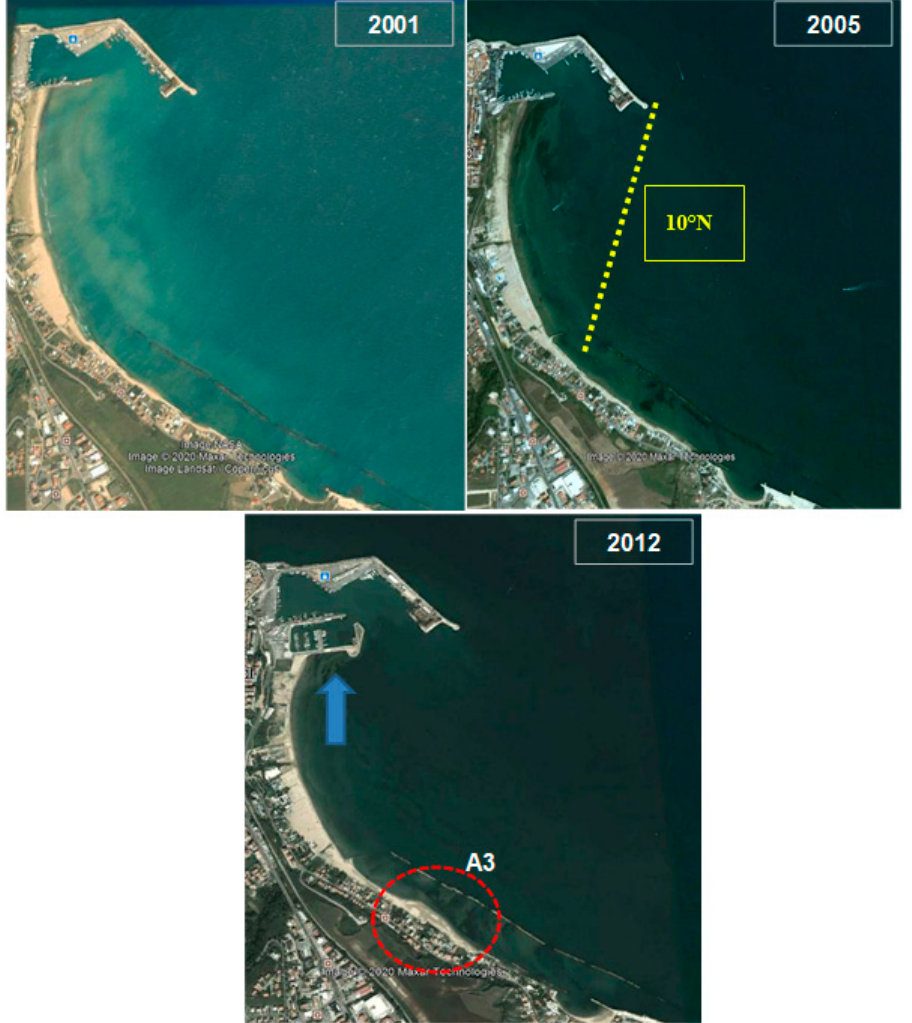
Figure 8. View of the area A3. Yellow dotted straight line represents sheltering by 10° N waves. (Section 5).